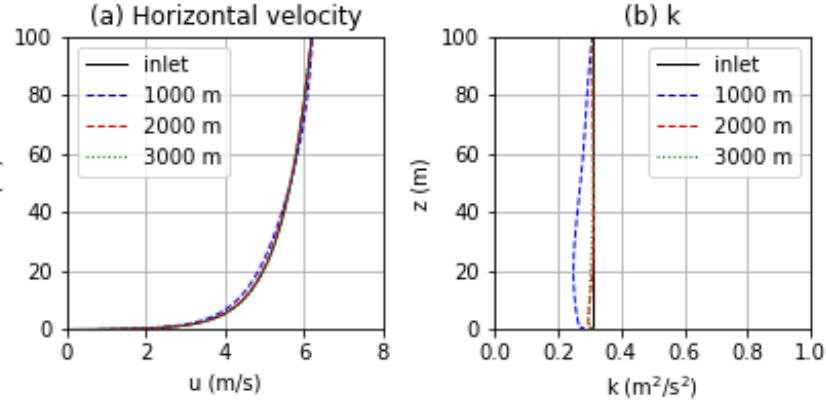
Figure 2. Comparison of the numerical profiles along the length of the domain, and the reference profile applied as the inlet boundary condition for the NBL: ( a ) horizontal velocity and ( b ) turbulent kinetic energy.